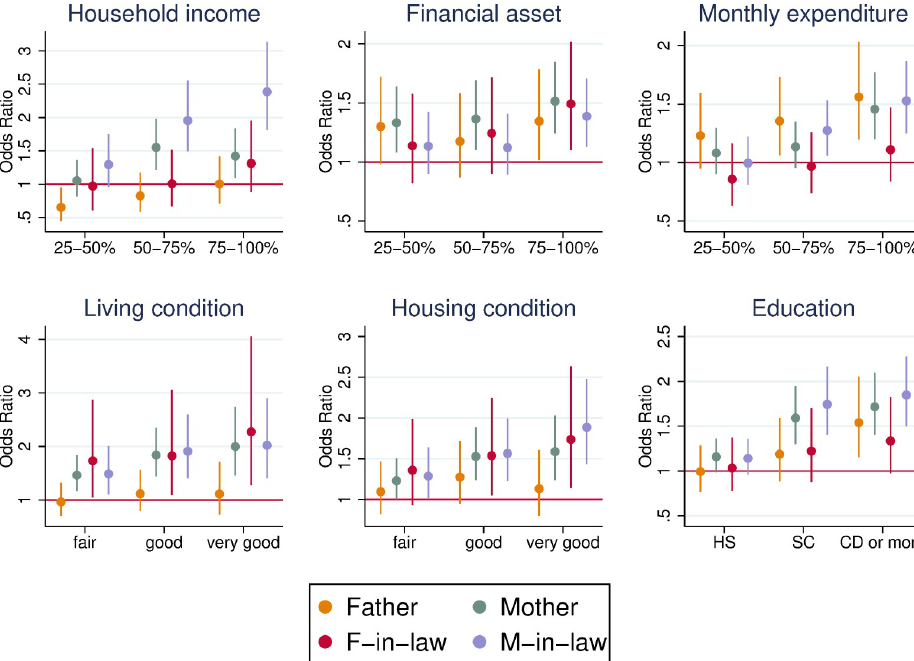
Fig 2. Odds ratio of survival of own parents and parents-in-law by SES. The figure shows the odds ratio of survival based on logistic regressions controlling for age and age squared, gender, and marital status (for father and mother, married and not widowed or divorced = 1) of the respondents. The bars represent the 95% confidence interval. The dependent variable is a binary variable that takes unity if the father, mother, father-in-law, or mother-in-law is alive at the time of the survey, and zero otherwise. Each panel shows a different SES measure. The sample of the analysis consisted of all respondents in the dataset. The number of observations ranges from 3,030 (parents-in-law for household income) to 7,100 (parents for living and housing